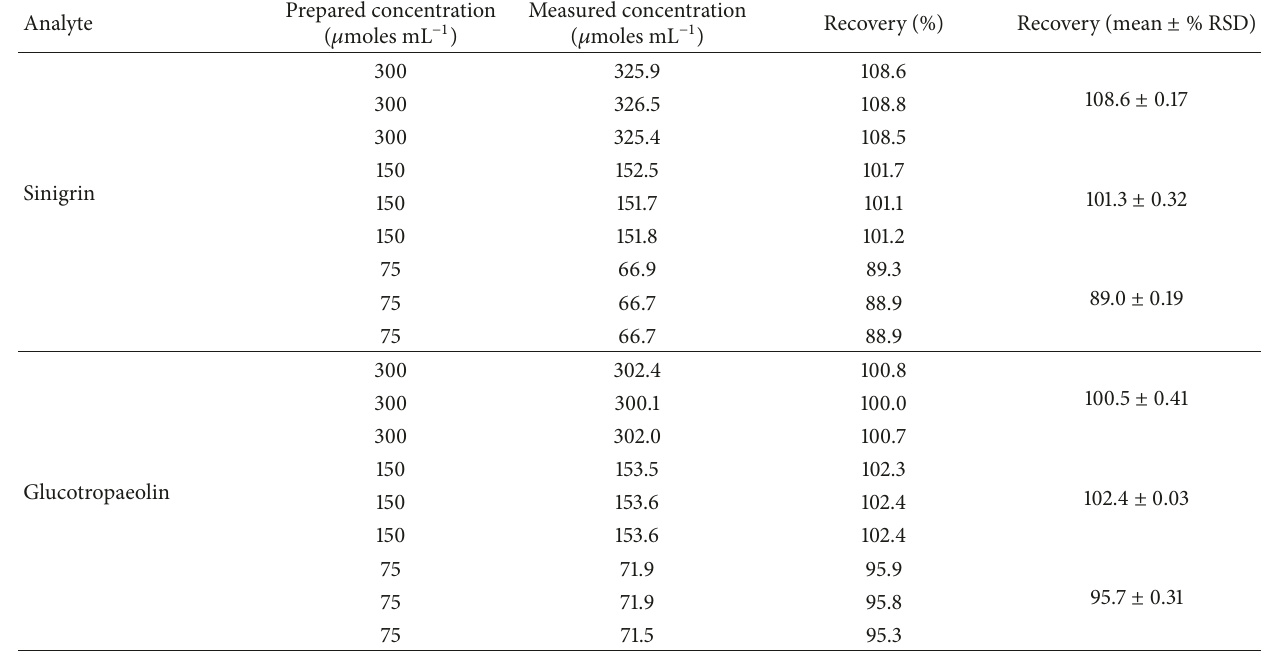
Table 3: Accuracy of HPLC system used for glucosinolates